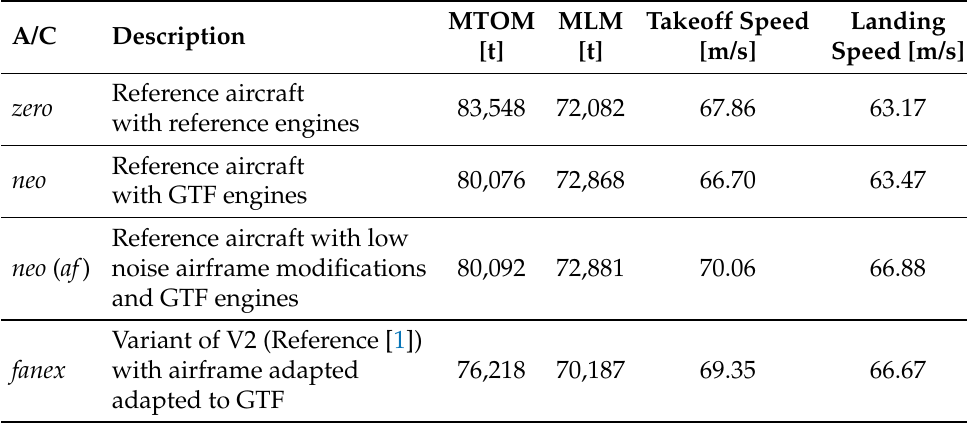
Table 4. Design aspects of applied aircrafts from previous system noise study